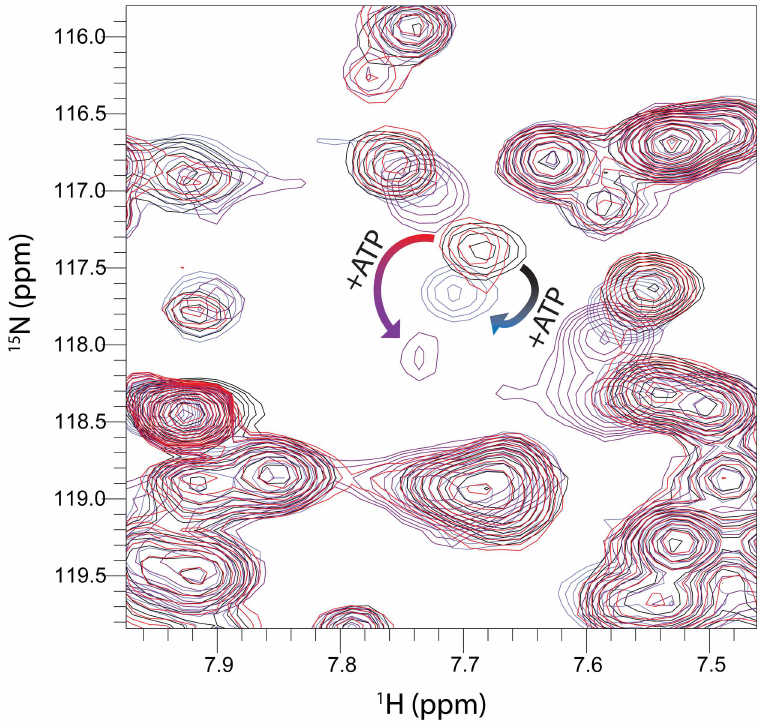
Fig 4. Region of 15 N HSQC of FGFR2 kinase. Curved arrows indicate chemical shift perturbations that occur to the Arg664 shift as ATP analogis added.Black/bluespectra are of the unphosphorylated kinase, whilered/purplespectra are of the phosphorylated